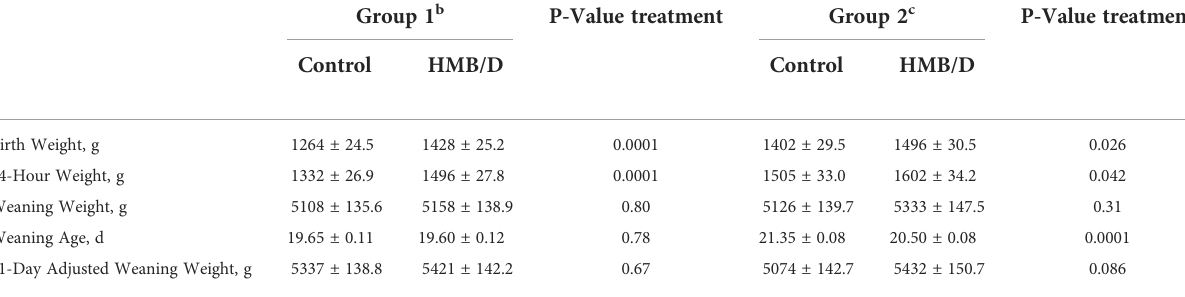
TABLE 6 The effect of supplementing calcium beta-hydroxy-beta-methylbutyrate and vitamin D (HMB/D) during late gestation and lactation on piglet weights by group.